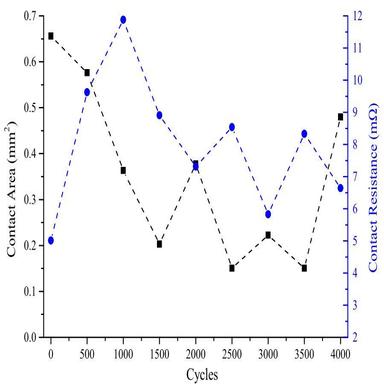
Variations of real contact area and measured resistance as a function of the number of switching operations.